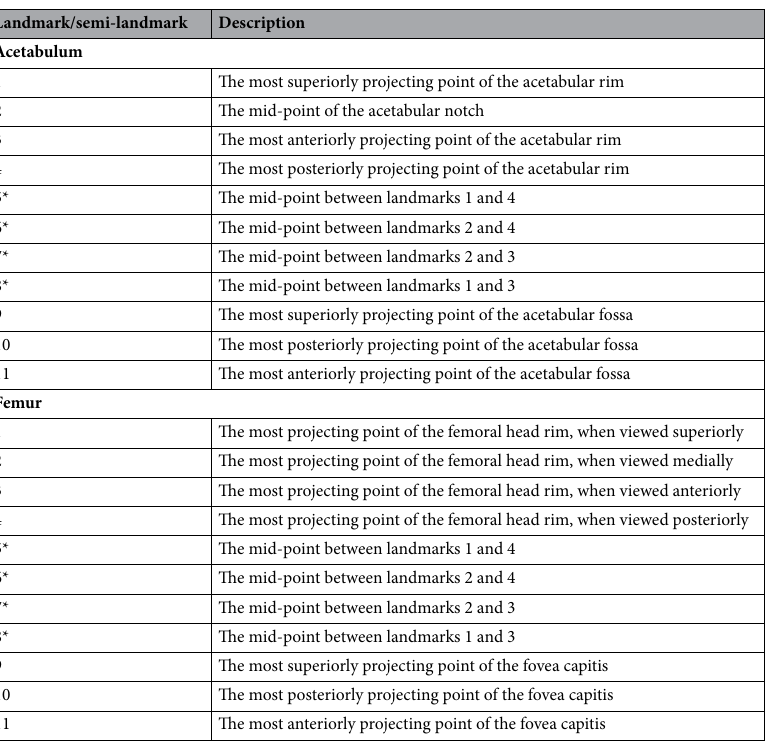
Table 2. Landmark and semi-landmark descriptions of the acetabulum (1–11) and the femur (1–11). The symbol (*) refers to